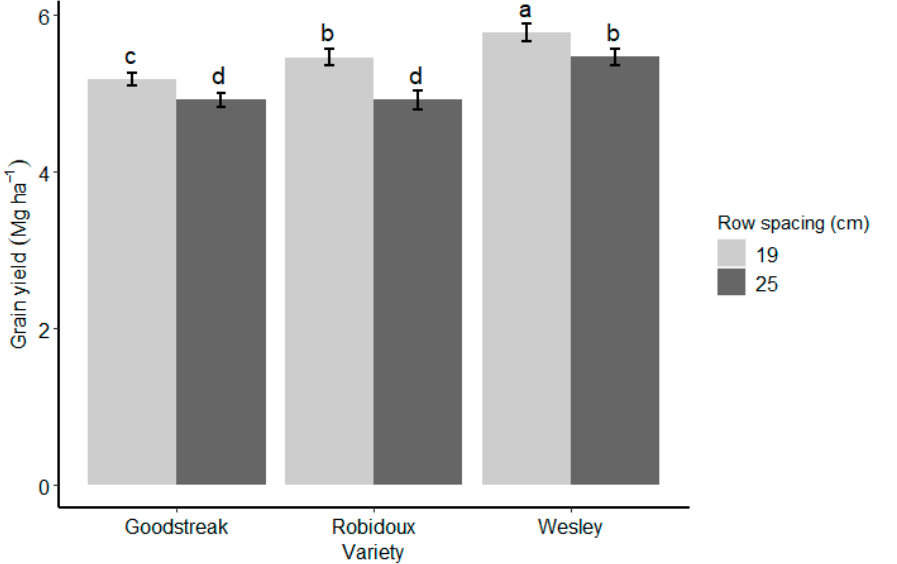
Figure 1. Winter wheat grain yield as affected by the interaction between row spacing and variety at Hemingford. The error bars represent the standard error of the mean. Different letters on top of column bars indicate a significant mean difference at p < 0.05 .